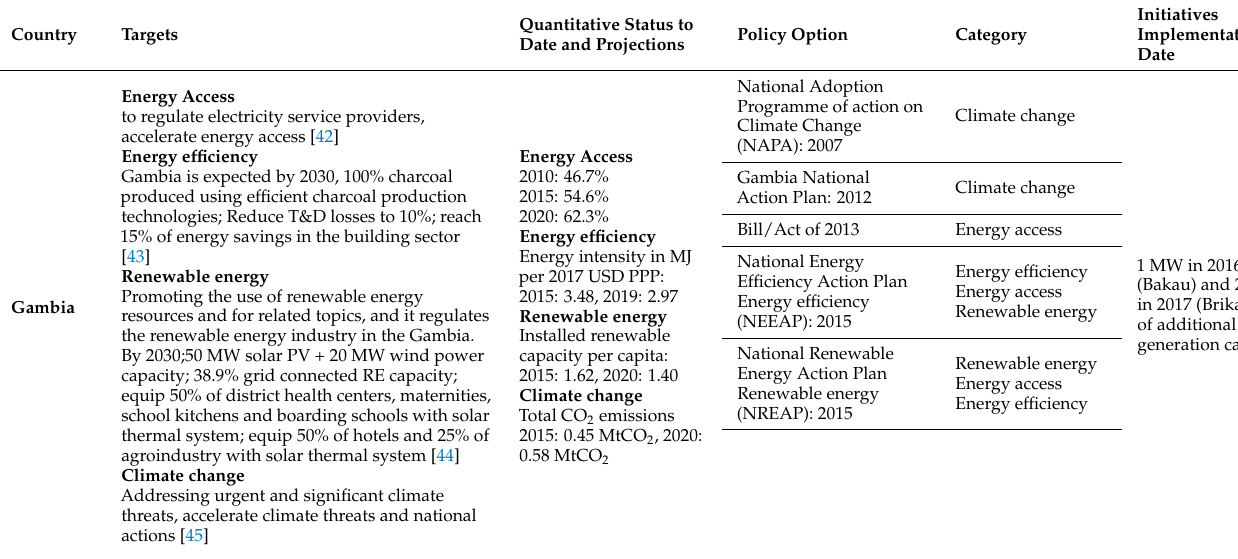
Table 5. Gambia (data from